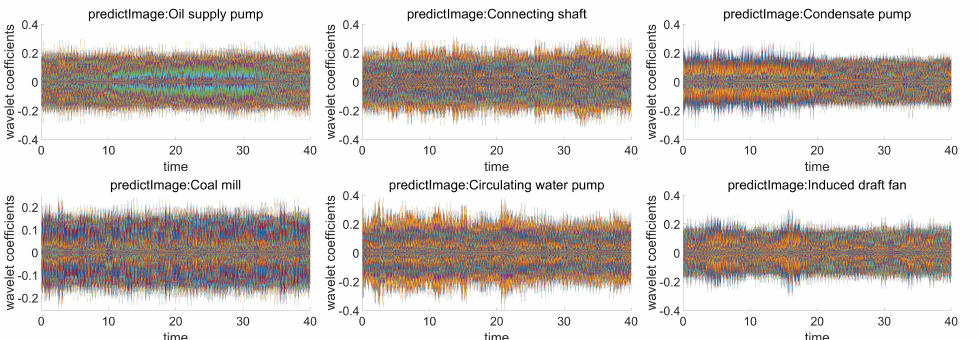
Figure 5. Equipment classification after adding 20 dB Gaussian white noise. The abscissa represents time, and the ordinate represents wavelet